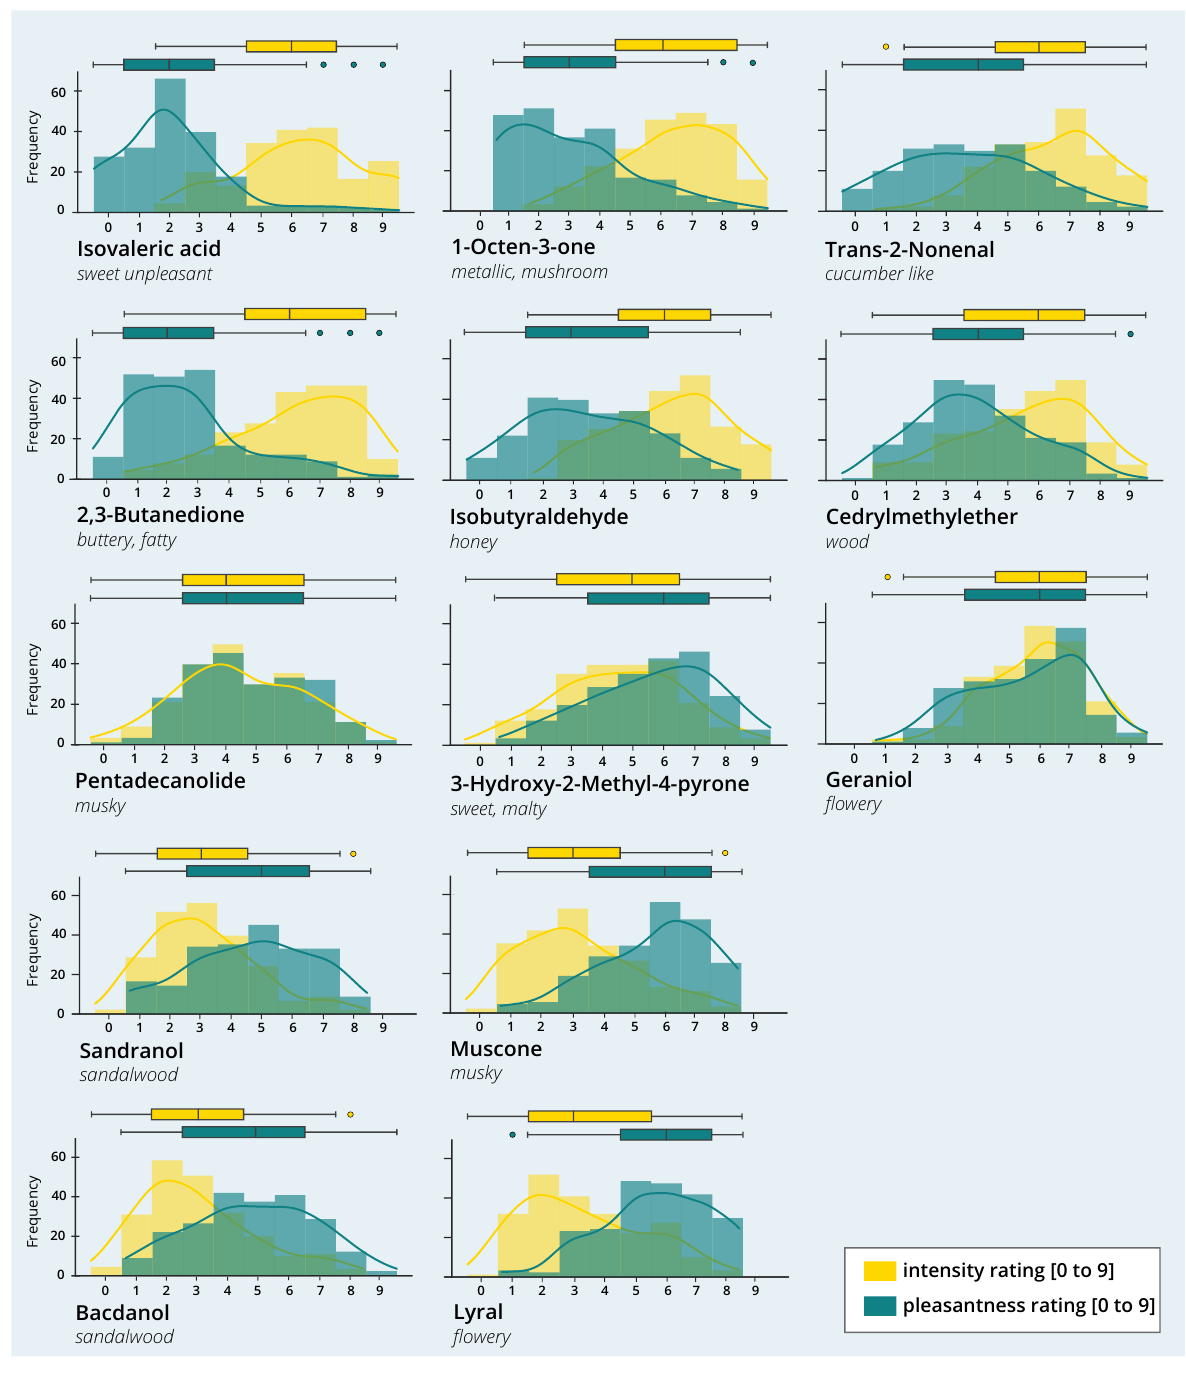
Figure 6. Distribution of Pleasantness and Intensity Ratings. The histogram plots illustrate the frequency (= total number of ratings) for perceptual ratings of pleasantness and intensity for each odor. The plots are arranged in subgroups according to low, medium and high values in pleasantness (ranging from 0 = extremely unpleasant to 9 = extremely pleasant) and intensity (ranging from 0 = not perceived to 9 = extremely intense). In order to give an idea of the qualitative impression of the odors, a semantic description is added for each. Circles indicate